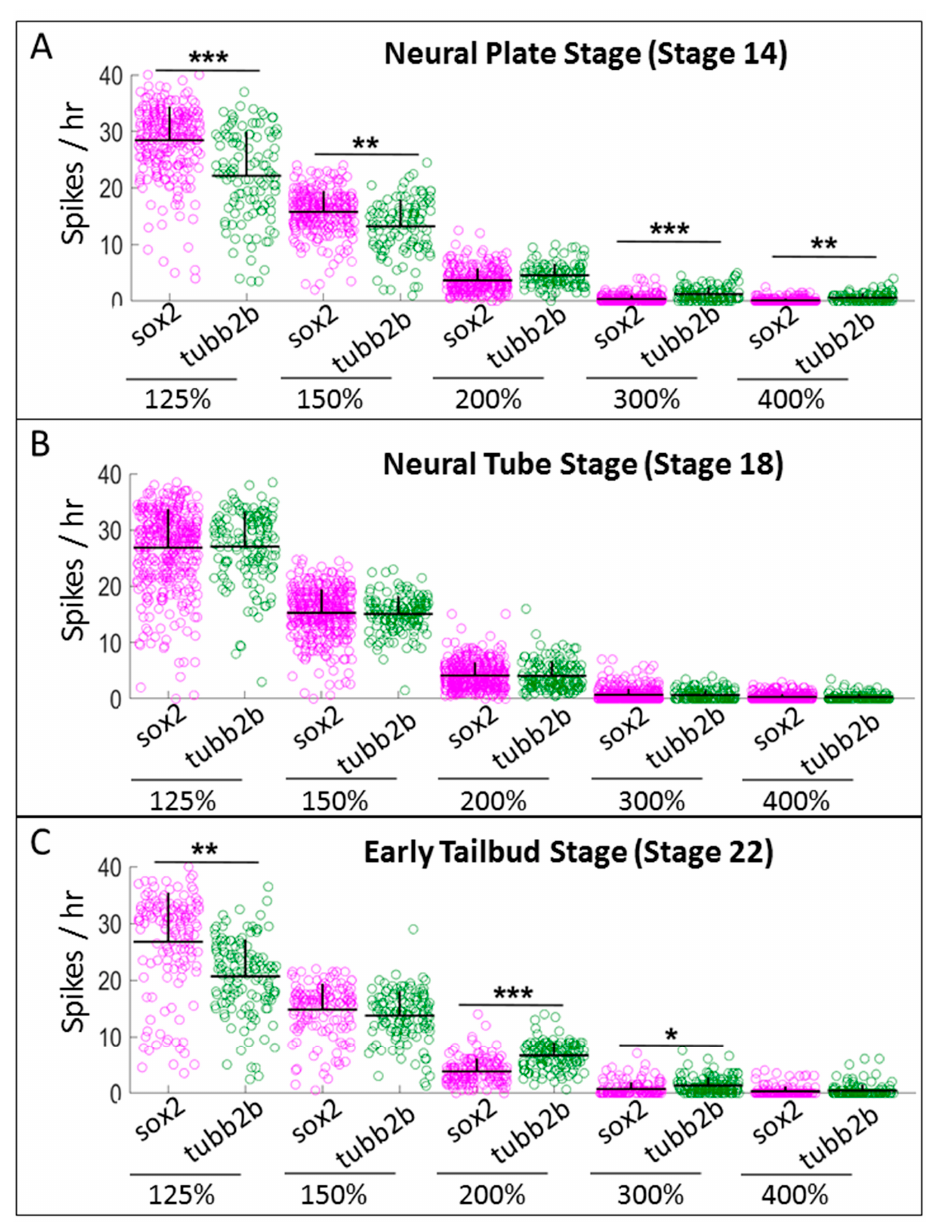
Figure 4. Neural progenitor cells exhibit high numbers of small spikes and lower numbers of high-amplitude spikes, but differentiated neurons exhibit a lower number of small spikes and larger number of high-amplitude spikes. Comparison of spiking frequency counted using five different thresholds (125%, 150%, 200%, 300% and 400% of baseline), between neural progenitor cells ( sox2 ) and differentiated neurons (tubb2b) at :( A ) neural plate stage (Stage 14); ( B ) neural tube stage (Stage 18); and ( C ) early tailbud stage (Stage 22). Stars represent statistically significant differences according to both Bonferroni-corrected two-sample Kolmogorov–Smirnov Test ( p < 0.05) and Cohen’s d statistics for effect size (mean + SD; n = 5 cultures; * 0.2 ≤ |d| < 0.5, ** 0.5 ≤ |d| < 0.8, *** |d| ≥ 0.8).